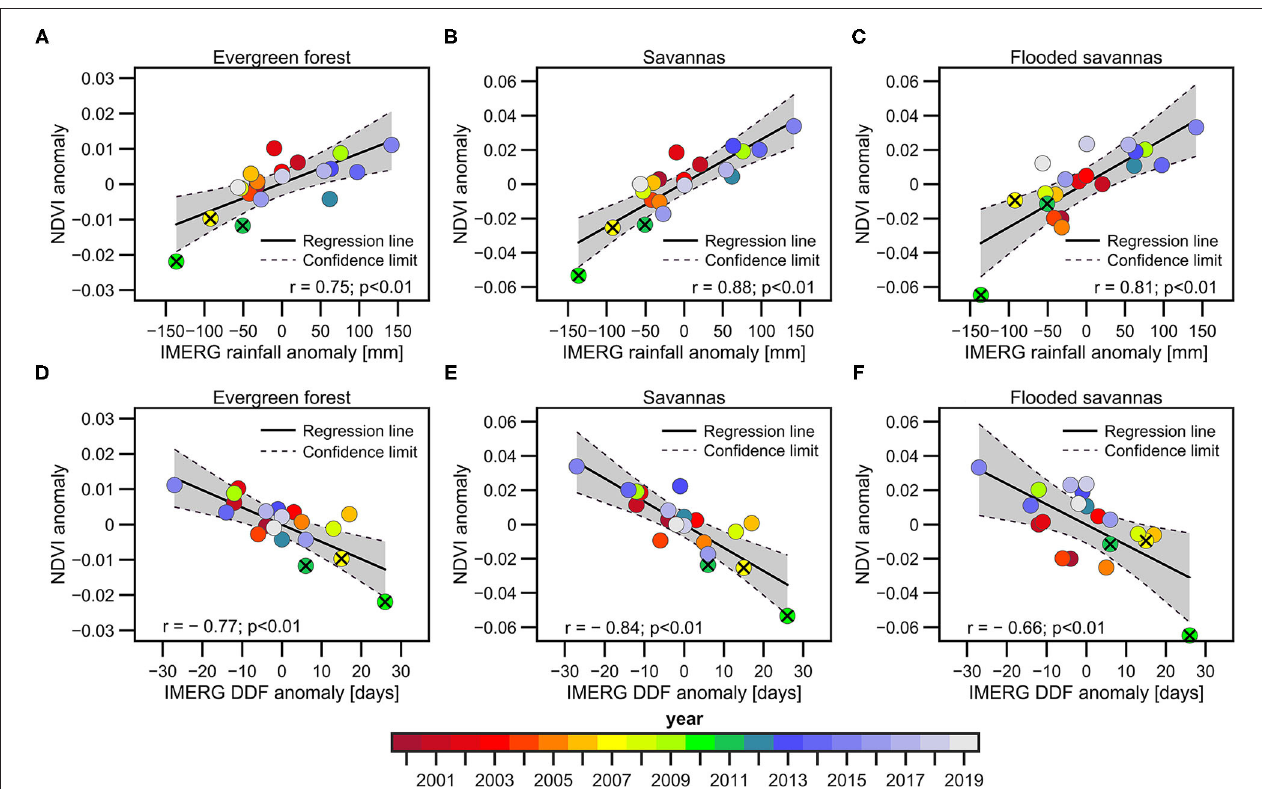
FIGURE 6 | Scatter plots between NDVI anomalies for the three predominant land cover types during the VDS in the 2000–2019 period and: precipitation anomalies (A–C) and the DDF (D–F) during the PDS in the upper Madeira Basin. Precipitation and DDF anomalies are estimated using GPM-IMERG data. NDVI anomalies for each predominant cover type [evergreen forests in (A,D) , savannas in (B,E) , flooded savannas in (C,F) panels] are calculated below the 1,000m.a.s.l. The corresponding years, the regression line, the confidence interval (95%), the correlation coefficients and the p -value are indicated in panels (A–F) . The extreme drought years (2007, 2010, and 2011) are indicated with the X